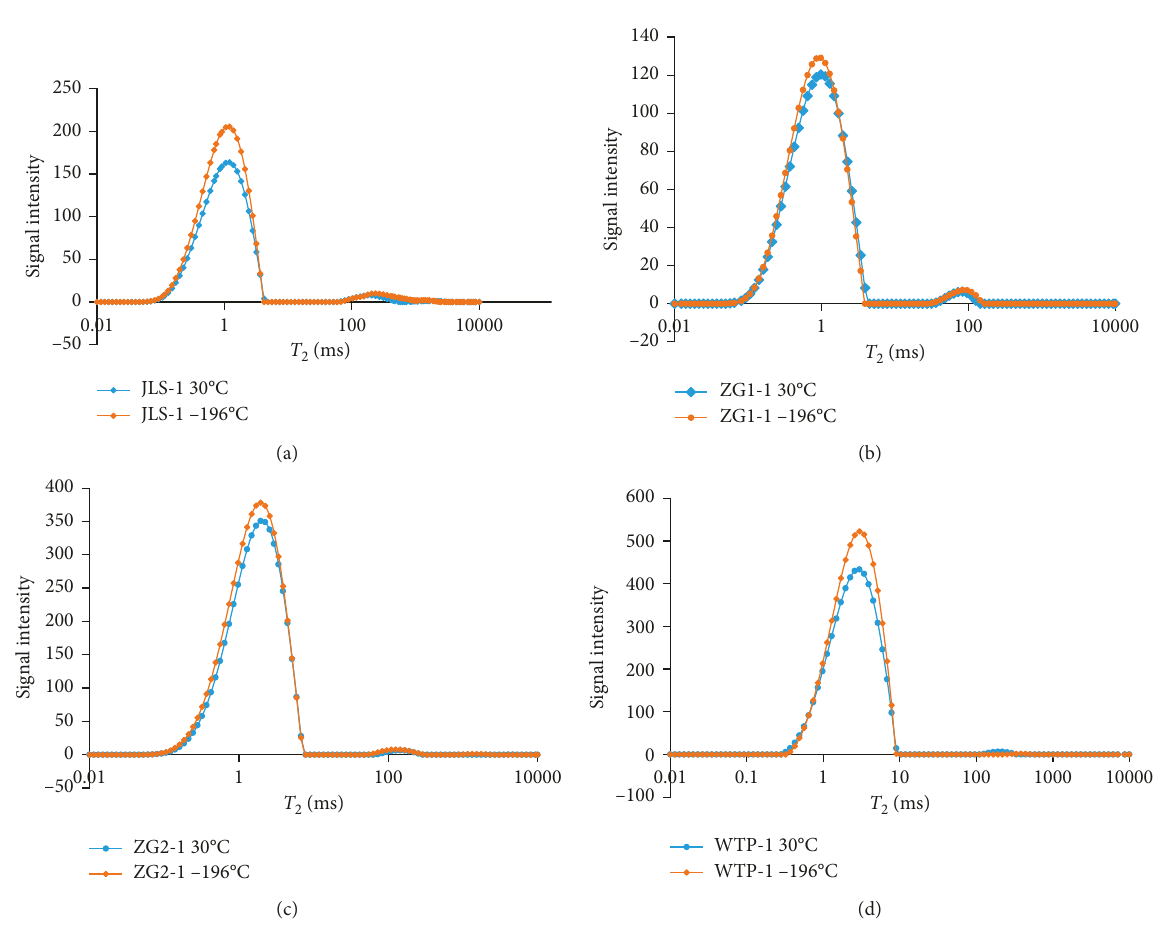
Figure 1: T 2 spectra of coal samples under low-temperature